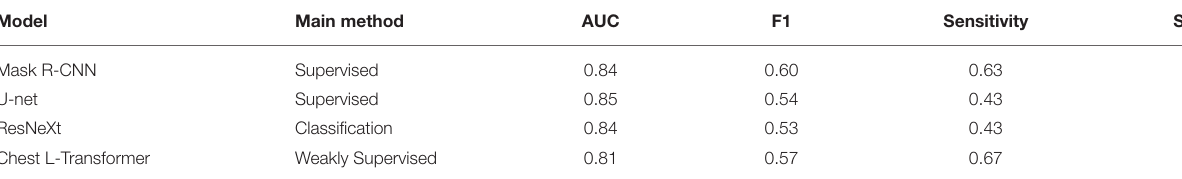
TABLE 1 | Comparison of Chest L-Transformer with the state-of-the-art models (classification). Model